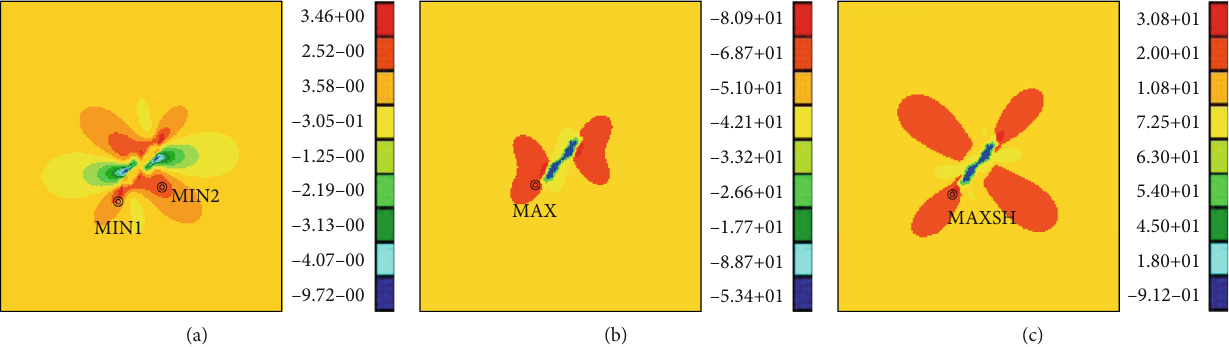
Figure 2: Stress fi eld around the existing fl aw: (a) minimum principal stress; (b) maximum principal stress; (c) maximum shear stress.